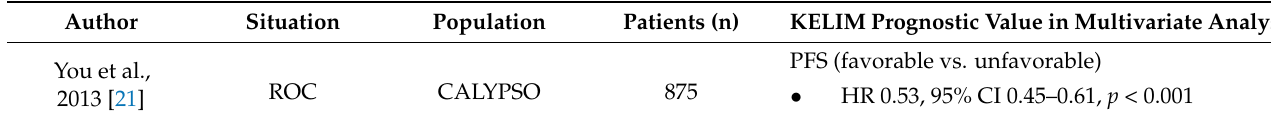
Table 1. Summary and main results of the articles on